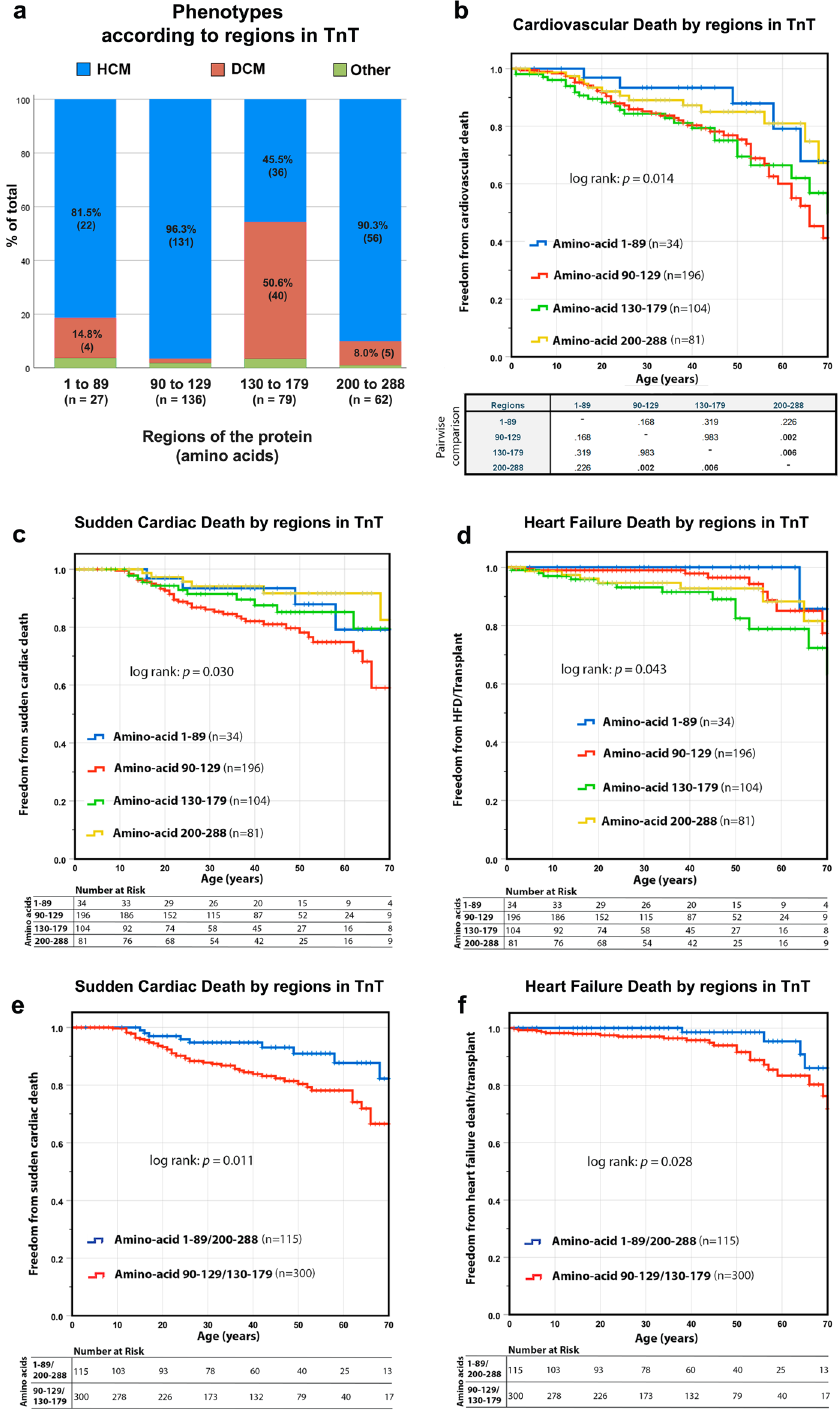
Fig. 6 Clinical outcomes of amino acid substitutions in TnT regions. a Phenotypes according to regions in the TnT protein. HCM is signi fi cantly more frequent among patients with variations at amino acids 90 – 129 than in other regions; the higher number of DCM cases is observed in substitutions at amino acid 130 – 179 ( p < 0.01). b Survival curve for the freedom from cardiovascular death in the four main regions of TnT; differences were statistically different between the groups ( p = 0.014). Pairwise comparison showed a worse prognosis for patients with variations at regions 90 – 129 and 130 – 179 than at regions 1 – 89 and 200 – 288. c Freedom from sudden cardiac death in the different regions of TnT; differences were statistically signi fi cant ( p = 0.030). Pairwise comparison showed a worse prognosis for individuals with variations in regions 90 – 129 and 130 – 179. d Freedom from heart failure death/transplant in the different regions of TnT; differences were statistically signi fi cant ( p = 0.043). Pairwise comparison showed a worse prognosis for patients with variants in region 130 – 179 against regions 1 – 89, 90 – 129 and 130 – 179. e , f The same analysis performed by dividing TnT into high risk regions 90 – 129 and 130 – 179, and apparent lower risk regions 1 – 89 and 200 – 288. The difference is signi fi cant for sudden cardiac death ( p = 0.011) and heart failure death/ transplant ( p =